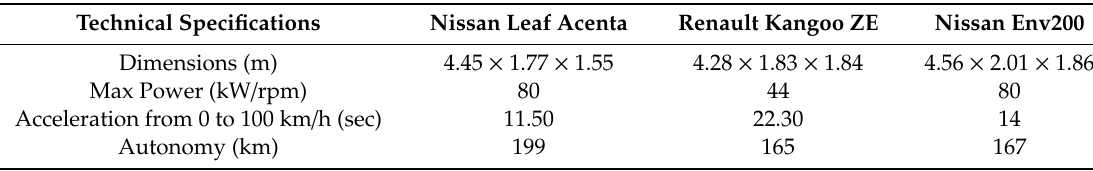
Table 1. Technical information of the electric vehicles